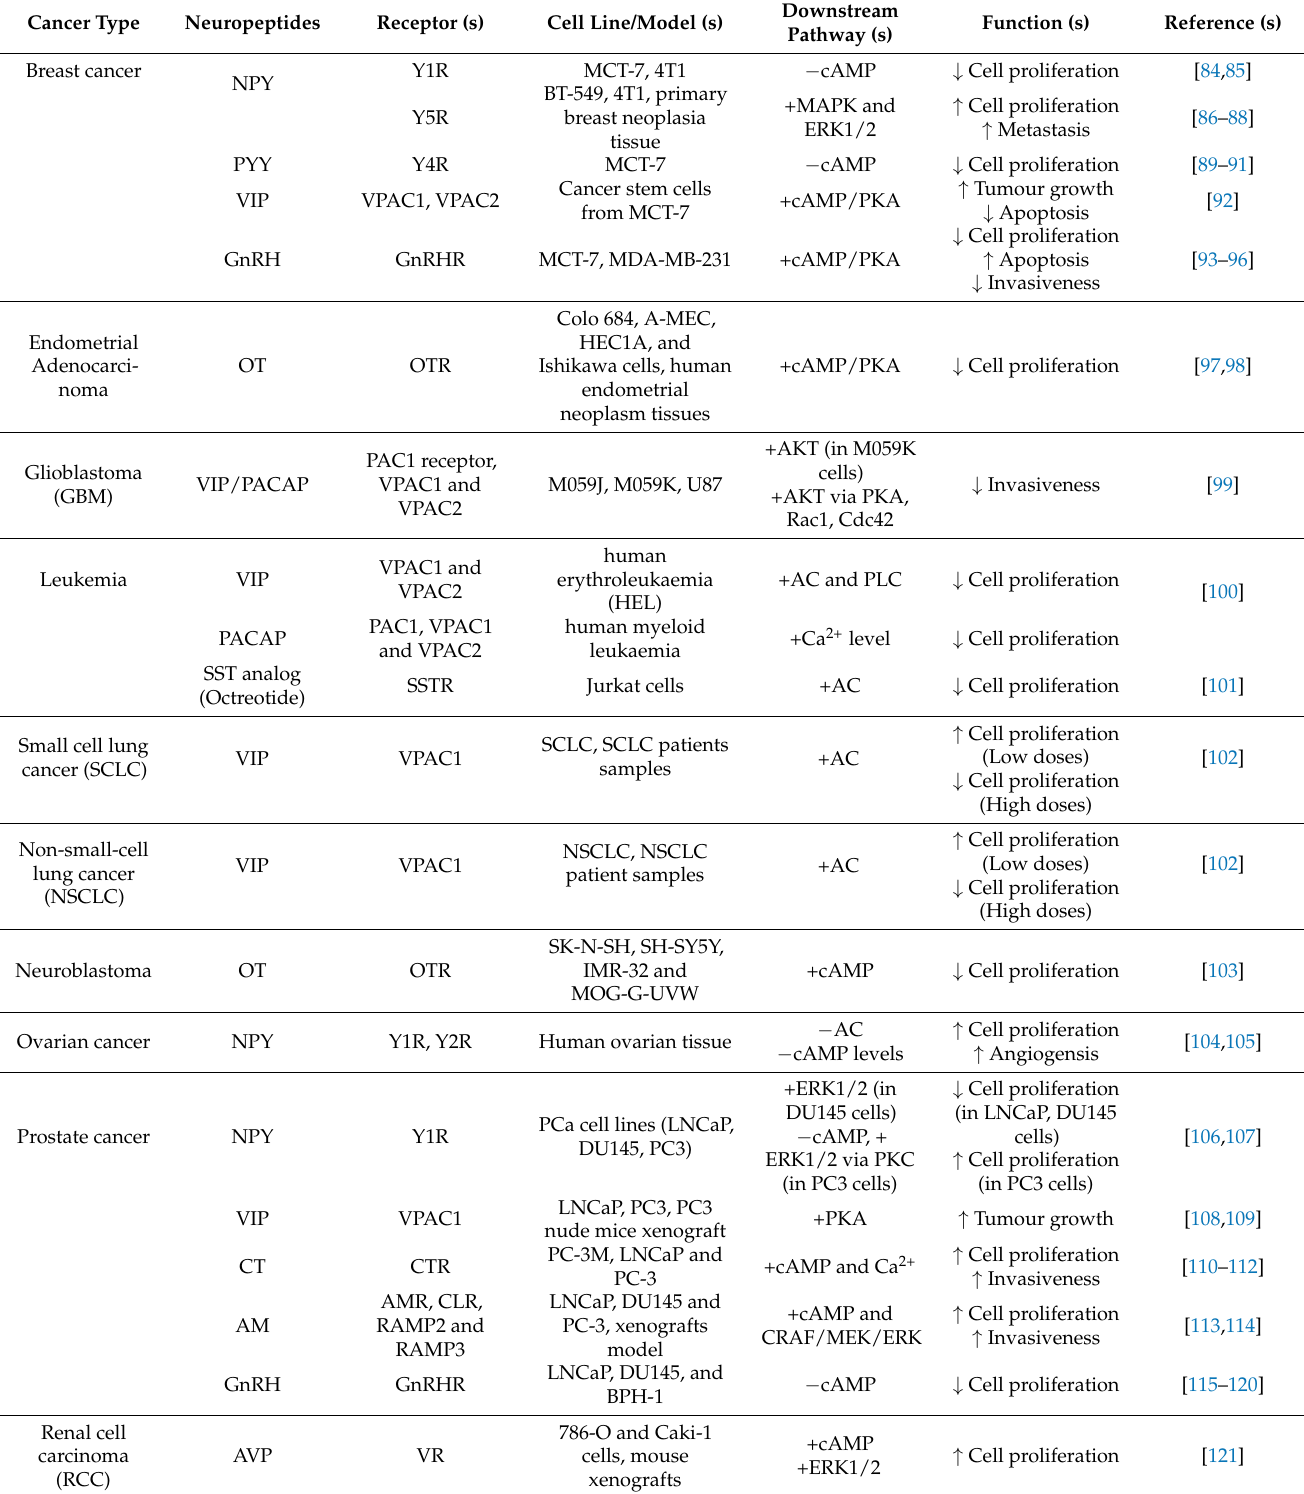
Table 2. Neuropeptides involving in tumour development through cAMP related pathways ( ↑ refers to up-regulation, ↓ refers to